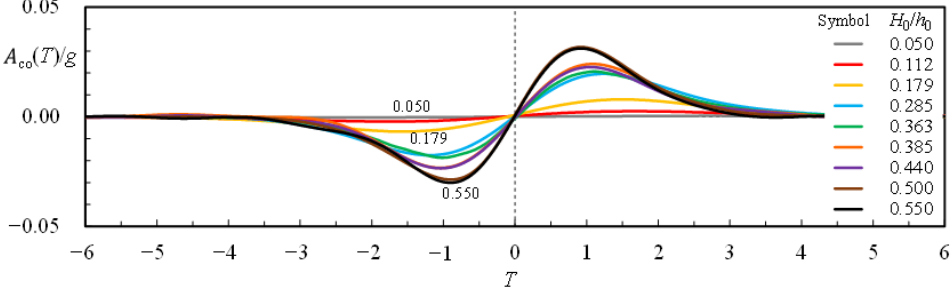
Figure 17. A comparison of temporal variations in the non-dimensional convective acceleration for H 0 / h 0 = 0.050–0.550. Note that the vertical scale used herein is distinct from that shown in Figure 15.